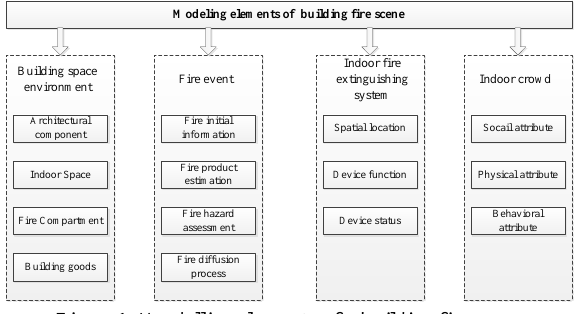
Figure 1. Modelling elements of a building fire